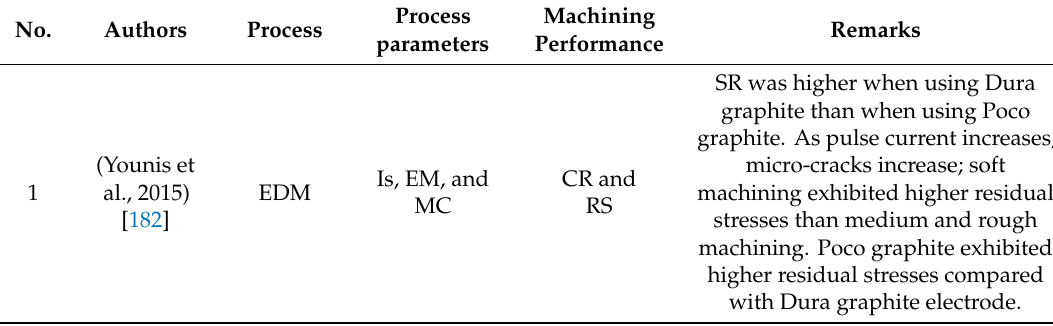
Table 3. Summary of recent researches in optimizing machining process parameters of tool